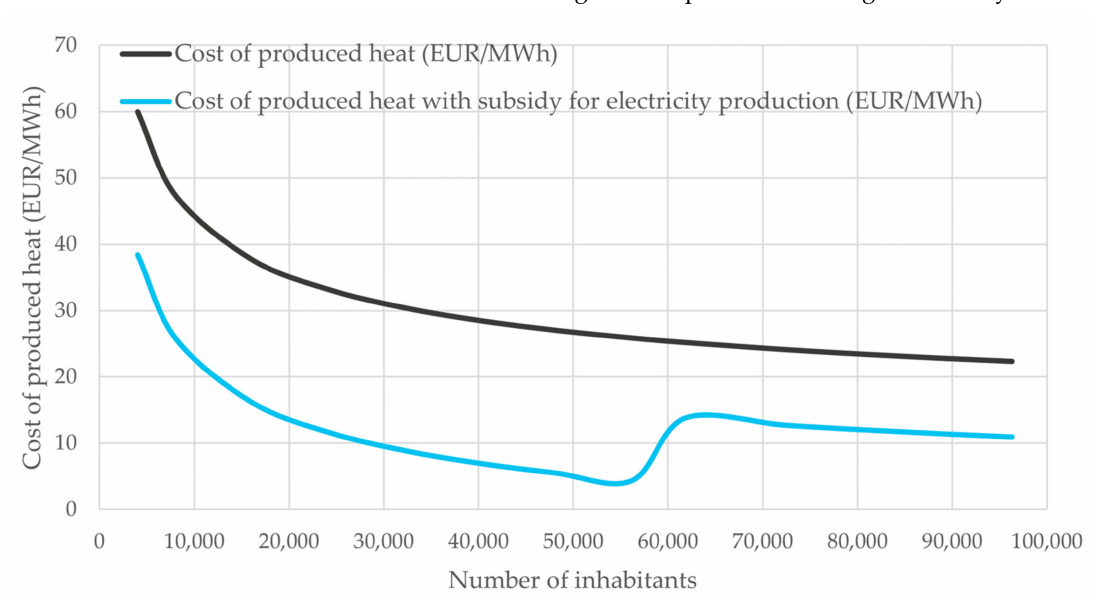
Figure 9. The cost price of heat produced from food